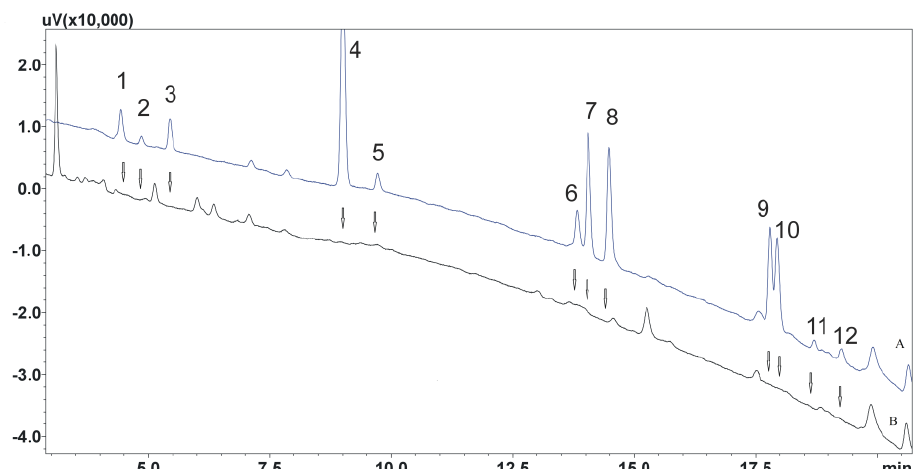
Figure 4. (A) Chromatogram of saliva sample extract obtained spiked with 100 ng/mL; (B) chro- matogram of blank saliva sample extract. (1) N–desmethylmirtazapine; (2)